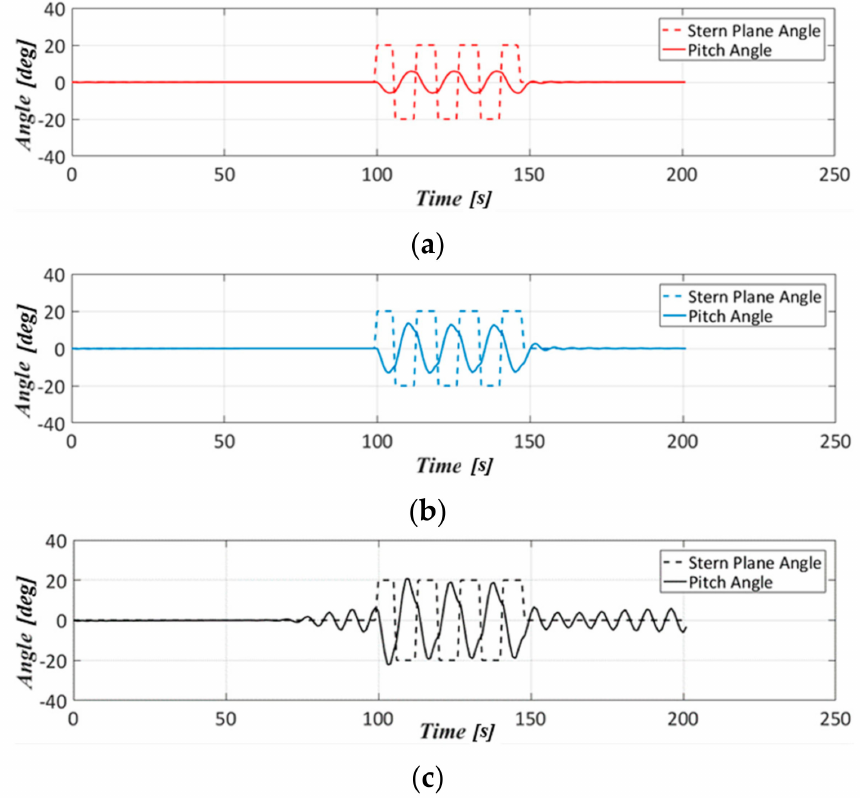
Figure 19. Comparisons of stern plane and pitch angles at sailing speeds of ( a ) U = 0.5, ( b ) U = 1, and ( c ) U = 1.5 m/s, respectively.